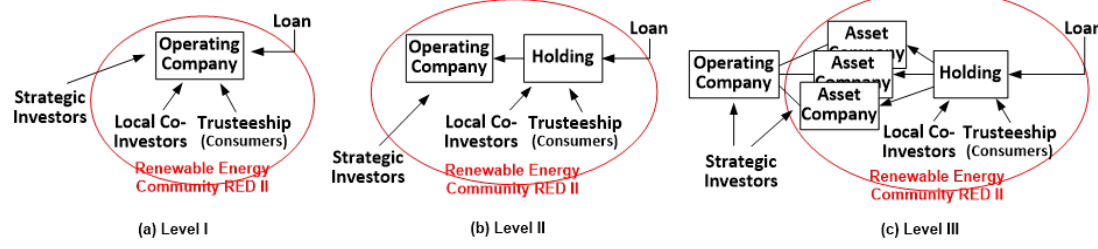
Figure 2. Co-investors in renewable energy communities (RECs). (Source: Own elaboration ).